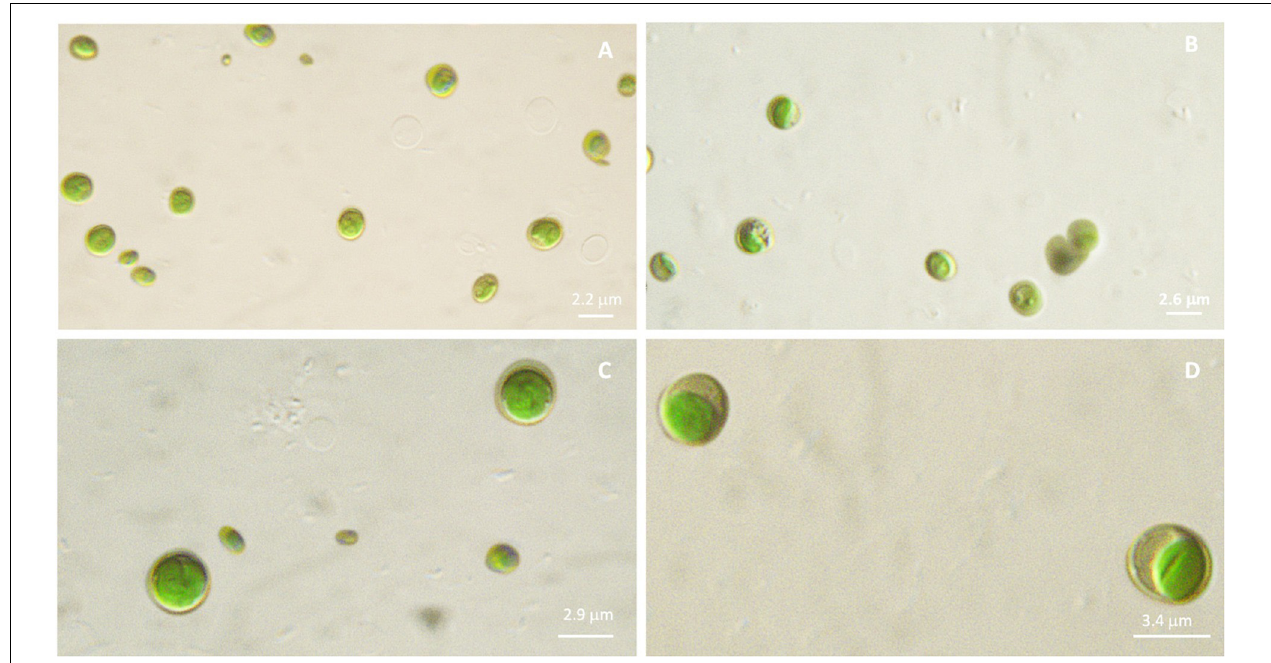
FIGURE 2 | Microscopic observation (100 × magnification, under mineral oil) of microalgal cultures in liquid TAP medium. (A) : Idr; (B) : FB; (C) : CL_Ch; (D) : CL_Sc.